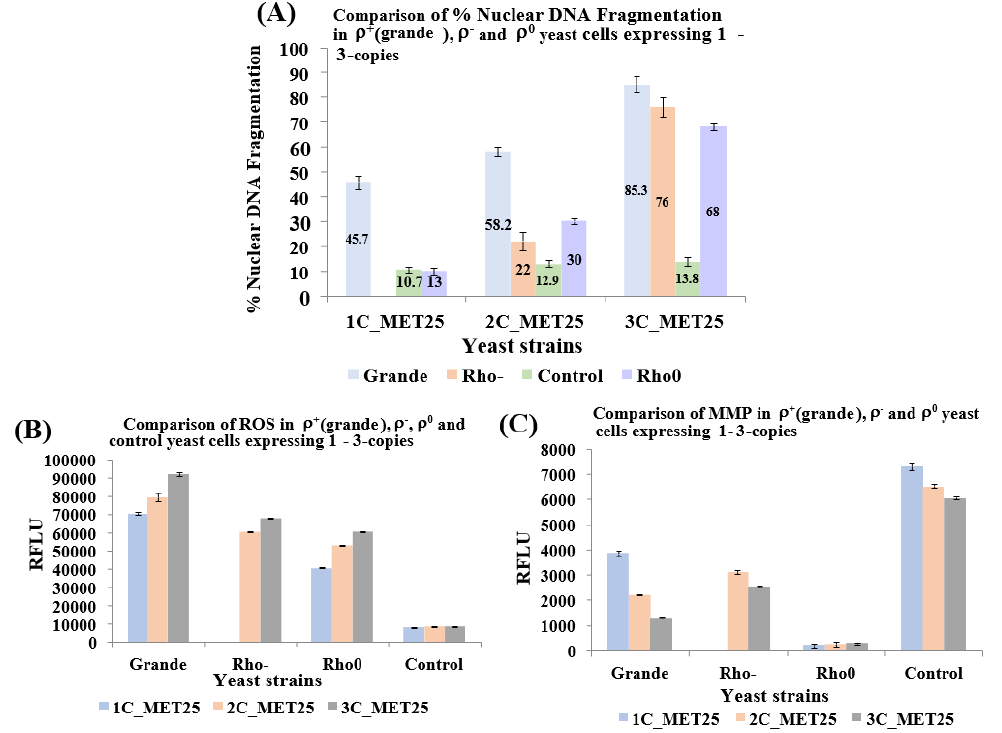
Figure 6. Analysis of nuclear DNA fragmentation ( A ), an increase of reactive oxygen species (ROS; B ), and loss of mitochondrial membrane potential (MMP; C ), in ρ 0 yeast cells that bear 1 to 3-copies of the human α -syn, gene under the control of the MET25 promoter. ( A ) Levels of nuclear DNA fragmentation, a hallmark of apoptosis, in yeast cells that express 1 to 3-copies of α -syn were assessed using the TUNEL assay. ( B ) Cells were stained with dihydroethidine to detect ROS. ( C ) Cells were stained with the JC-10 dye to quantify MMP loss. The data presented in ( A , B , C ) represent mean ± S.D. of three independent experiments ( p < 0.05).